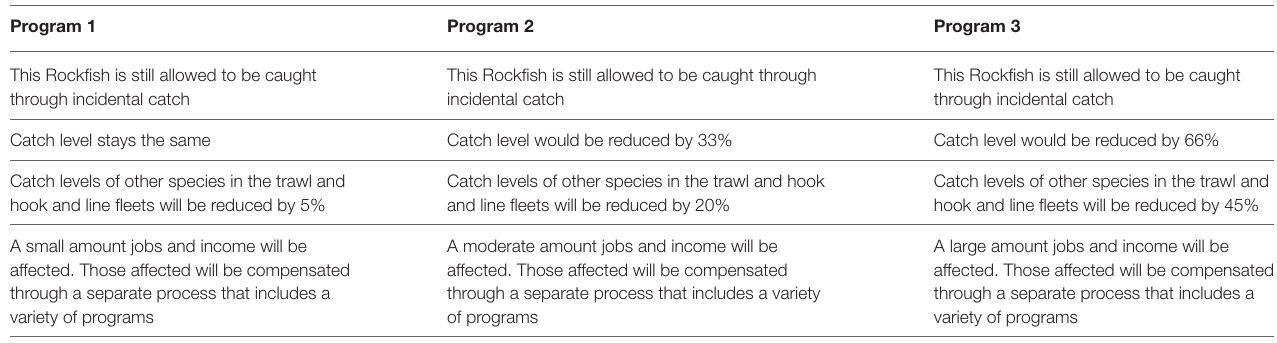
TABLE 1 | Management programs presented to